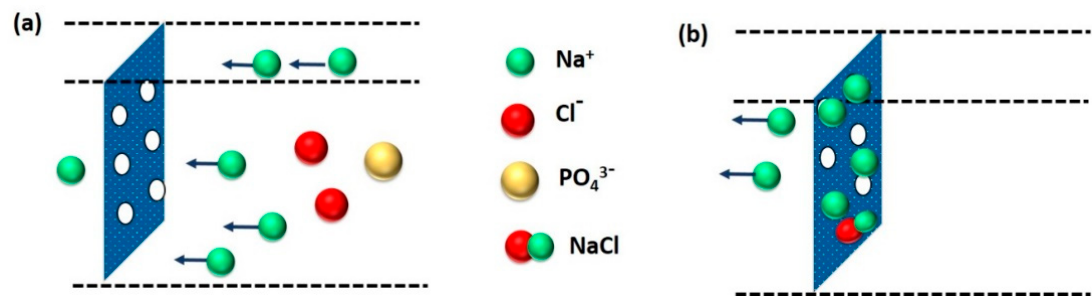
Figure 21. Two-stage separation of membrane comprising ( a ) size exclusion and ( b ) both size and charge exclusion.